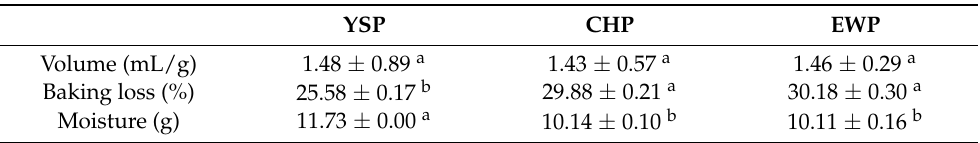
All values are expressed as mean ± standard deviation ( n = 3). Means with different superscripts (a,b) in each column are significantly different ( p < 0.05) according to Duncan’s test.